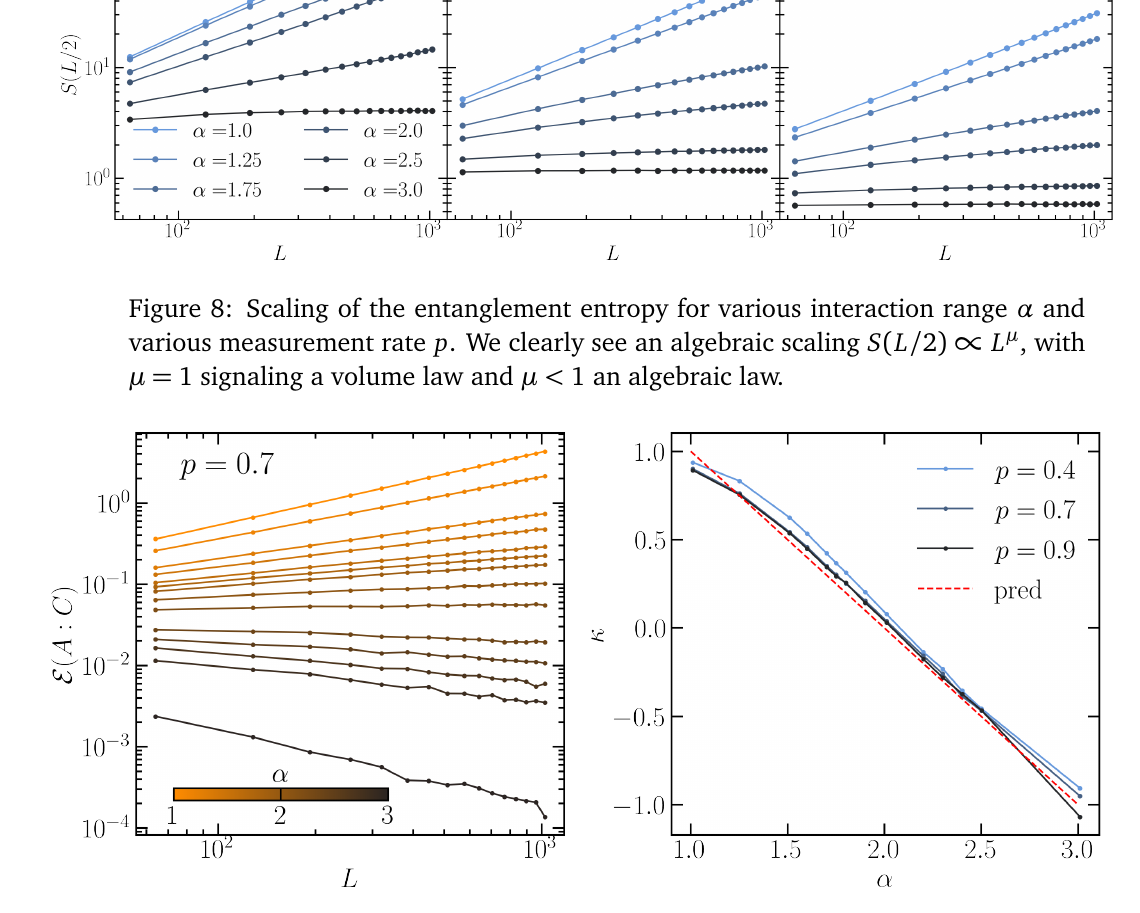
Figure 9: (Left) Scaling of the negativity for various interaction range α at high measurement rate p = 0.7 > p . (Right) Exponent κ extracted by fitting c E ( A : C ) = aL κ + b . Our results show a crossover between the region α (cid:166) 2 for which the negativity decreases with system size, and α (cid:174) 2 where the negativity in- creases with system sizes. The prediction given via the counting argument Eq. (17), valid at p → 1, is highlighted in